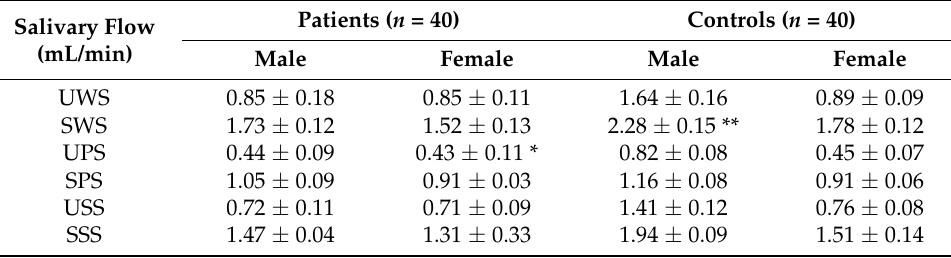
Table 1. Saliva flow rate of the studied groups (DM patient/control and stimulated/unstimulated). Salivary Flow